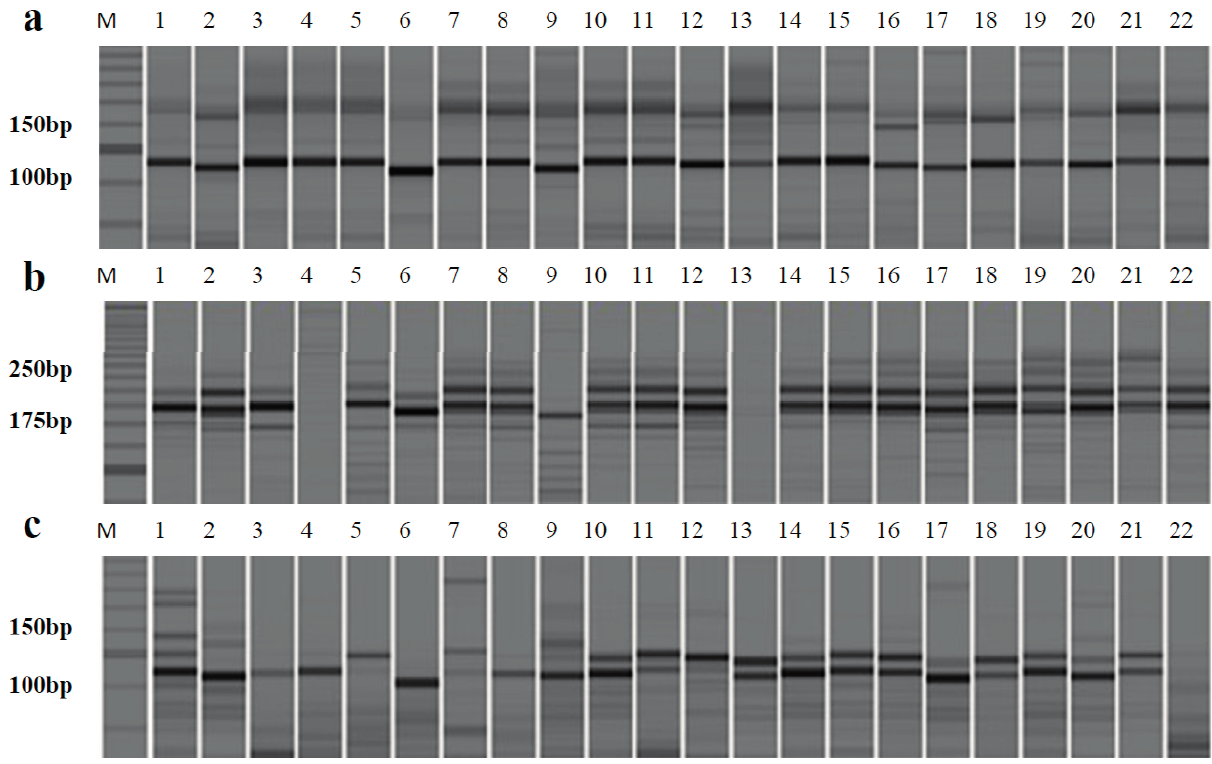
Figure 1. PCR amplification bands generated by the Welsh onion genic SSR markers MCL32 ( a ), MCL40 ( b ), and TO249 ( c ) in 22 Allium